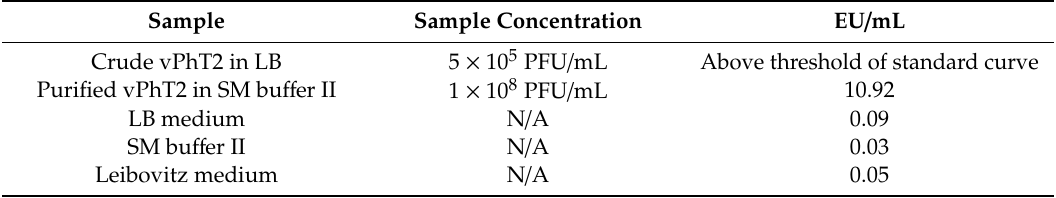
Table 6. Data on units of endotoxins measured in bacteriophage preparations.